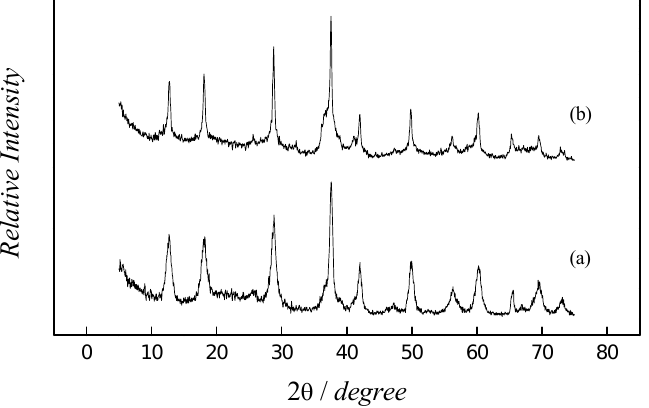
Figure 1. Powder X-ray diffraction pattern of hollandite-type manganese oxide prepared by: (a) redox precipitation, (b) sol-gel